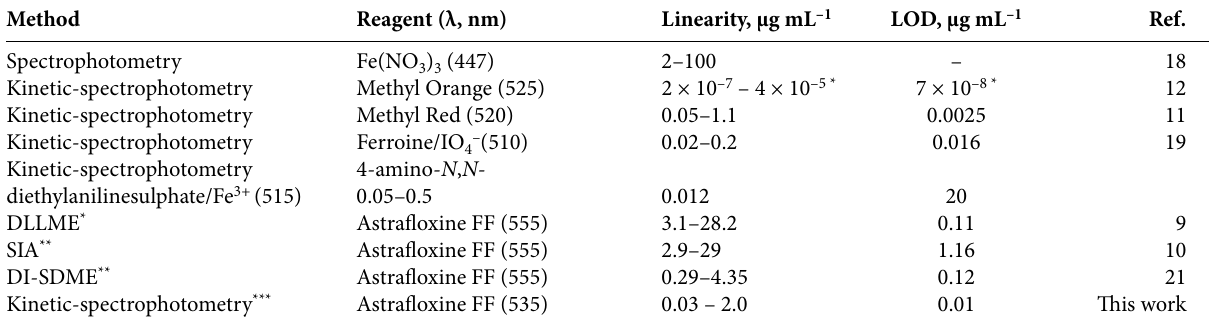
Table 2 . Comparison of the developed method with some other methods of thiocyanate determination with spectrophotometric detection Method